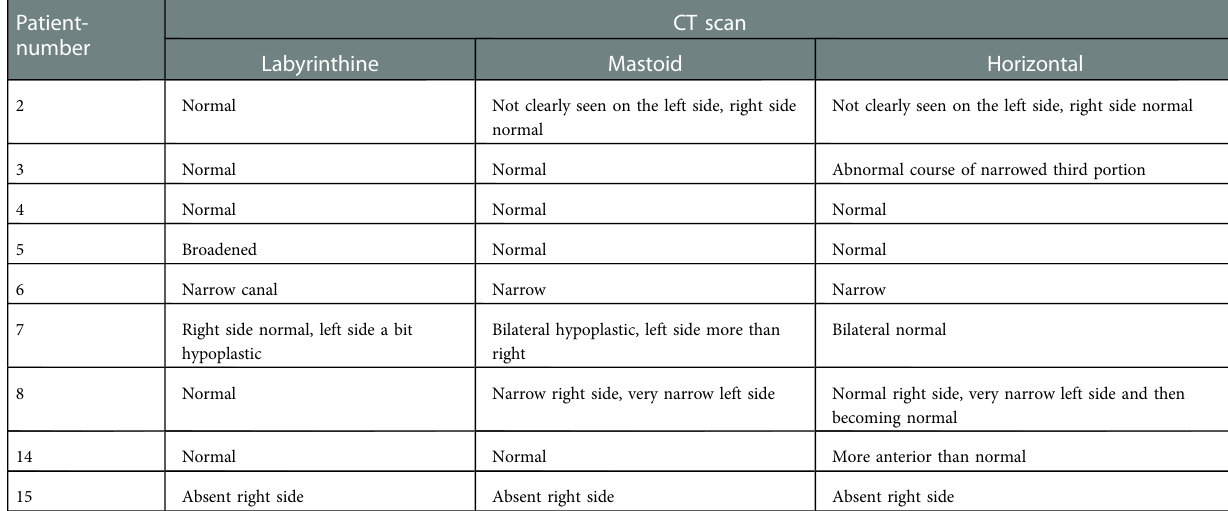
TABLE 5 Results CT